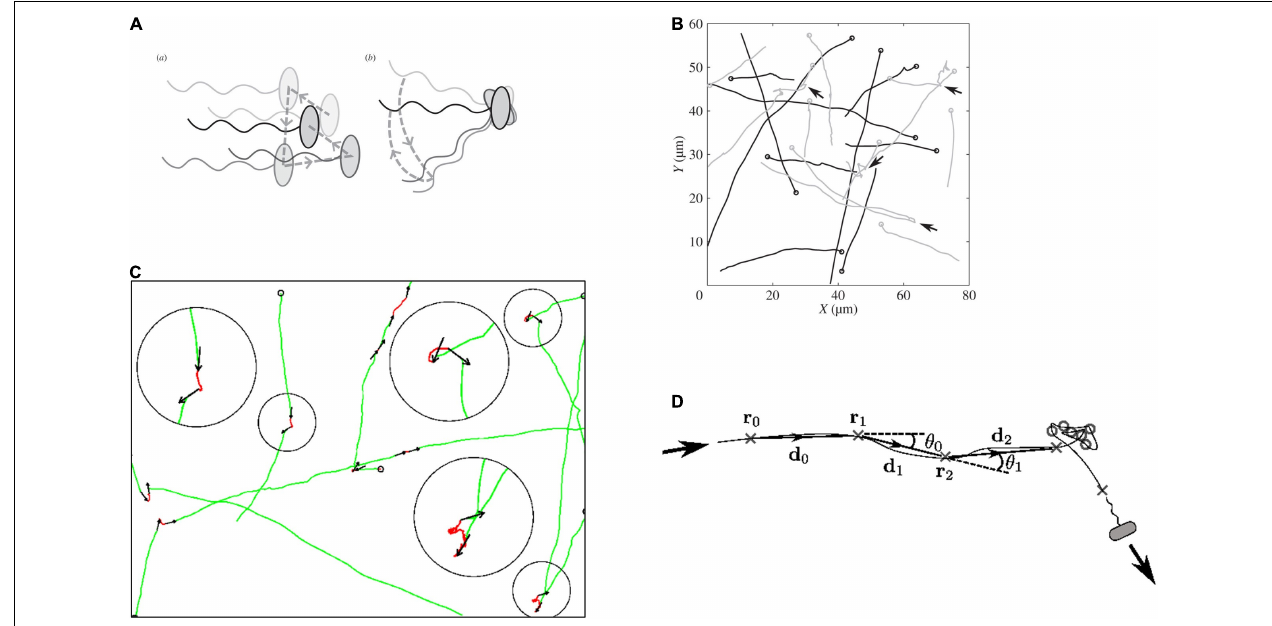
FIGURE 3 | Measurement of R. sphaeroides free swimming tracks. (A) Difference between rotational Brownian diffusion during a stop (a) vs. active reorientation (b). (B) Tracks with arrows marking stops, (C) details of movement during stops, and (D) analysis of angles changed while free swimming and stops (details in Rosser et al., 2013,